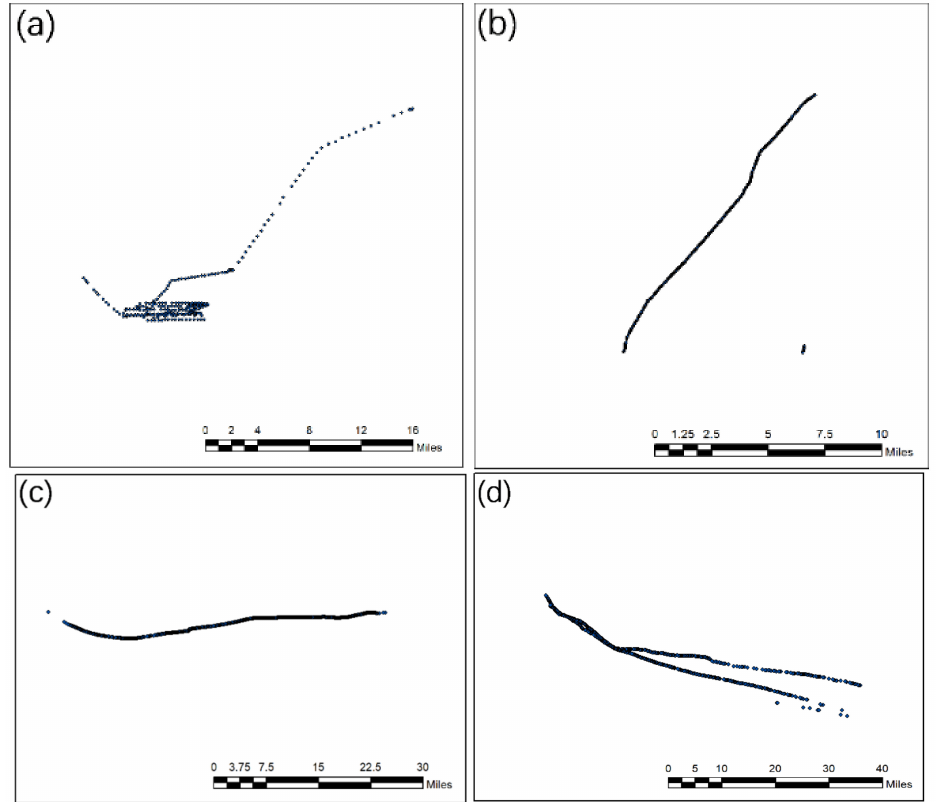
Figure 11. Trajectories of misclassified ships: ( a ) a fishing transport vessel misclassified as a trawler; ( b ) a trawler misclassi- fied as “other”; ( c ) a gillnetter misclassified as “other” and ( d ) a seiner misclassified as